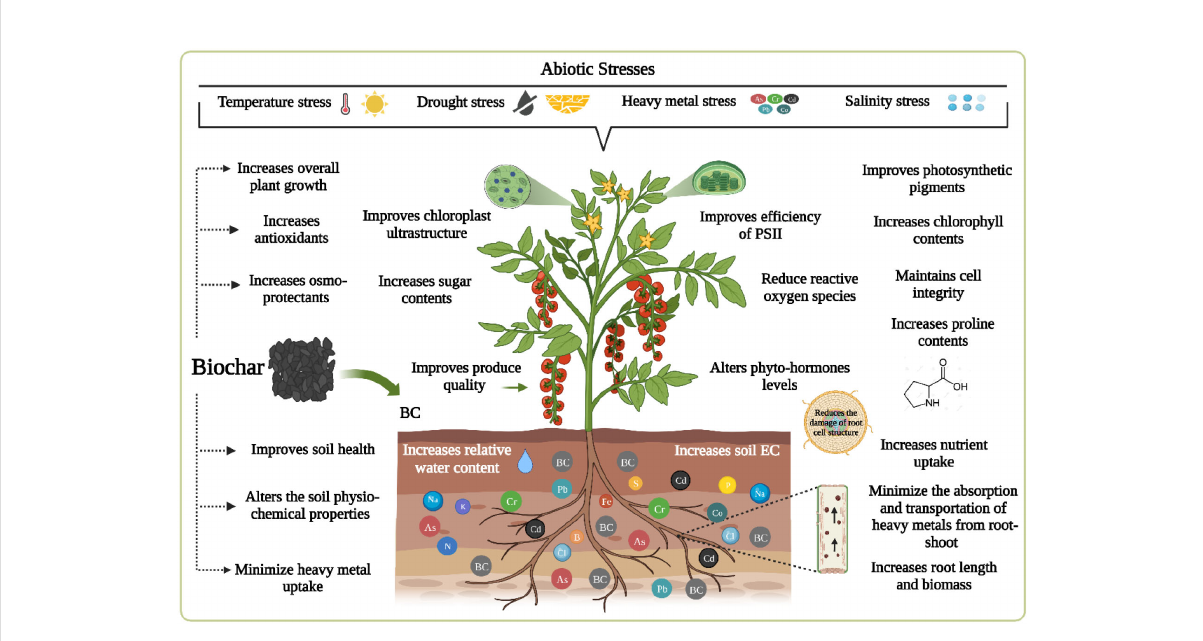
FIGURE 6 Positive impact of BC incorporation on plants under normal and stressed